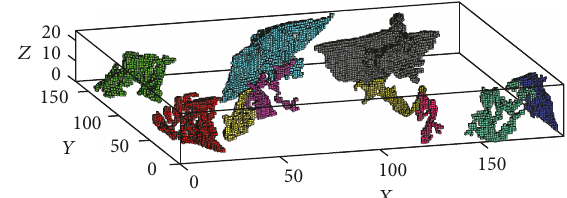
Figure 7: Largest percolating pore components inside the Callovo- Oxfordian clay sample.